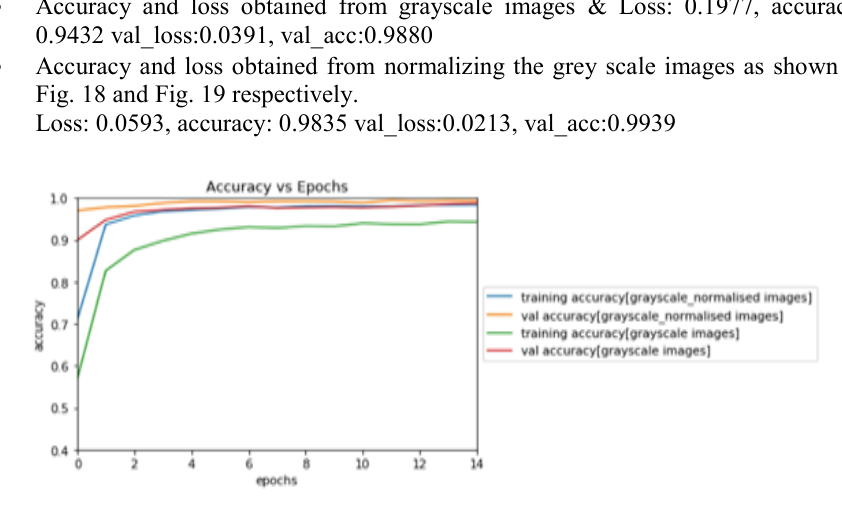
Fig.1 . Accuracy of normalized grey scaled images.